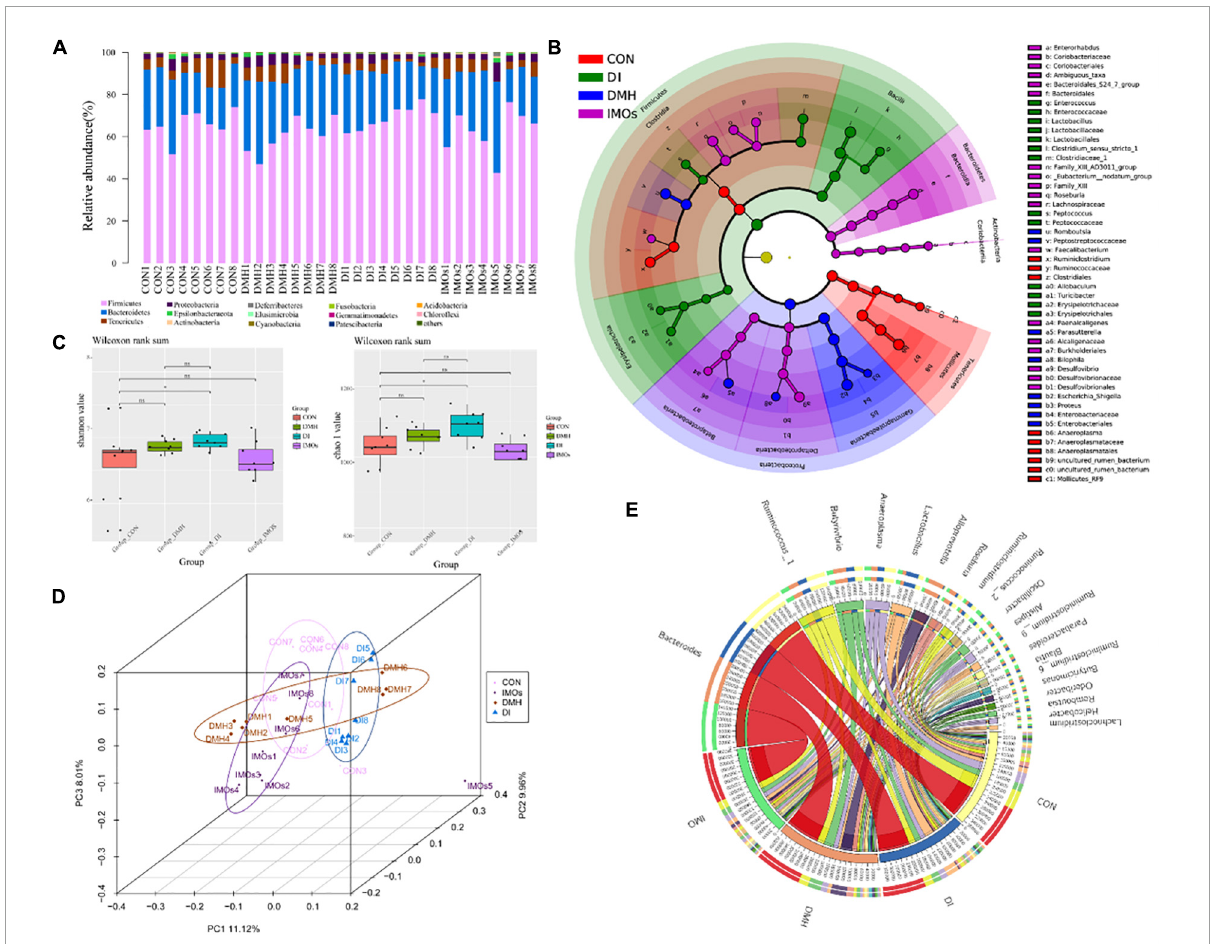
FIGURE4 Faecal microbiota effects of DMH treatment after 12 weeks of intervention with or without IMOs diet. (A) Relative abundances of phyla in the different groups. (B) Taxonomic abundance analysis (LEfSe analysis) revealed multiple differentially abundant taxa in different groups of faeces. (C) Microbial richness estimates (Chao index) and diversity indices (Shannon–Wiener) in the different groups. (D) PCoA shows separation of the faecal bacterial compositions among the four groups. (E) The chord diagram reveals the top 25 abundant genera (abundance > 0.1%) in the four